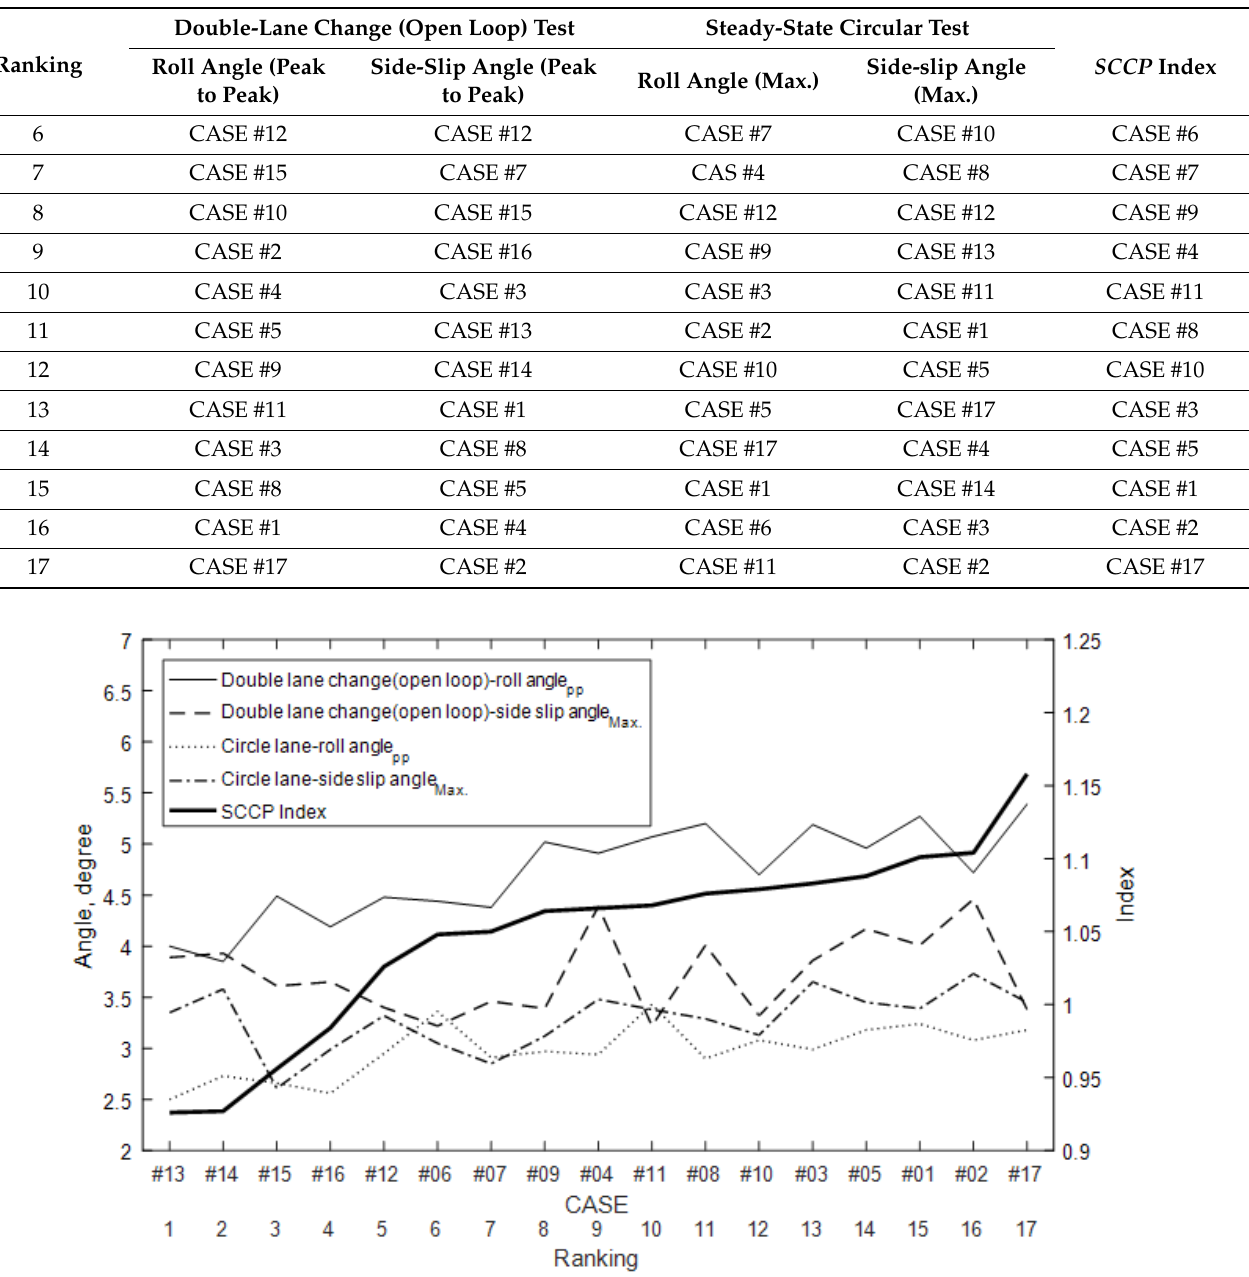
Figure 12. Suspension cornering performance index comparison.